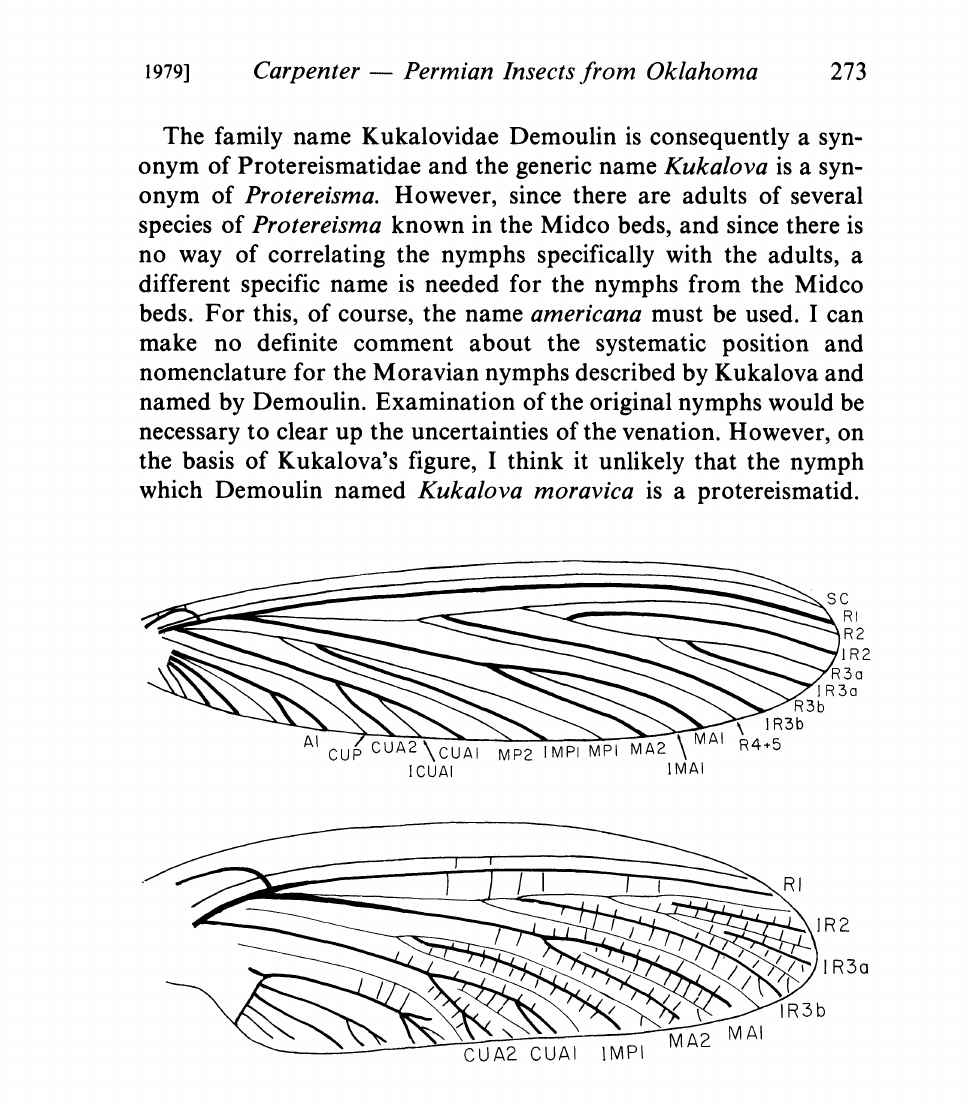
Figure 8. (above) Protereisma permianum Sellards. Diagram of venation of fore wing of neotype, MCZ 3405, Permian of Kansas. Convex veins are shown in heavy lines, concave veins in thin lines. Compare with figure 9. Lettering as in figure 2. A1, first anal vein; IR2, IR3, IMA, IMP, and ICUA, intercalary veins. Figure 9. (below) Protereisma americanum (Demoulin). Drawing of fore wing- pad, based mainly on MCZ 8637. Length of wing-pad, 5 mm. Compare with figures 8 and 10. Lettering as in figure 8, but only convex veins